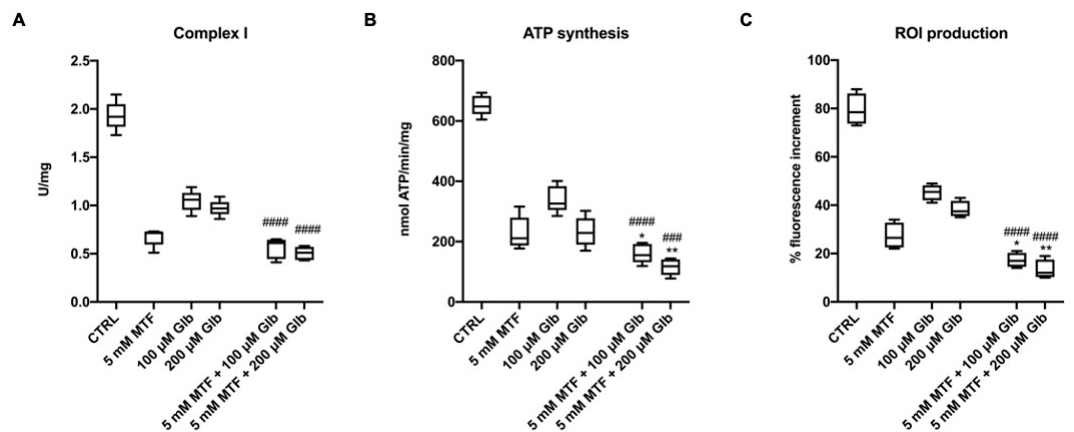
Figure 3. Effect of combination treatment with high doses of MTF and GLB on the aerobic metabolism and ROI production in rod OS. Figure reports the effect of the combination treatment compared with the single treatment. The used treatments are: 5 mM MTF + 100 µ M GLB and 5 mM MTF + 200 µ M GLB. ( A ) Complex I activity, expressed as uU/mg of total protein. ( B ) ATP synthesis trough F o –F 1 ATP synthase expressed as nmol of ATP produced/min/mg of total protein. ( C ) ROI production in rod OS exposed to the light. Data are from n = 5 independent experiments. * or ** indicate a significant difference for p < 0.05 or 0.01, respectively, between the combination treatment and 5 mM MTF treatment. ### or #### indicate a significant difference for p < 0.001 or 0.0001, respectively, between the combination treatment and the respective exclusive GLB treatment.